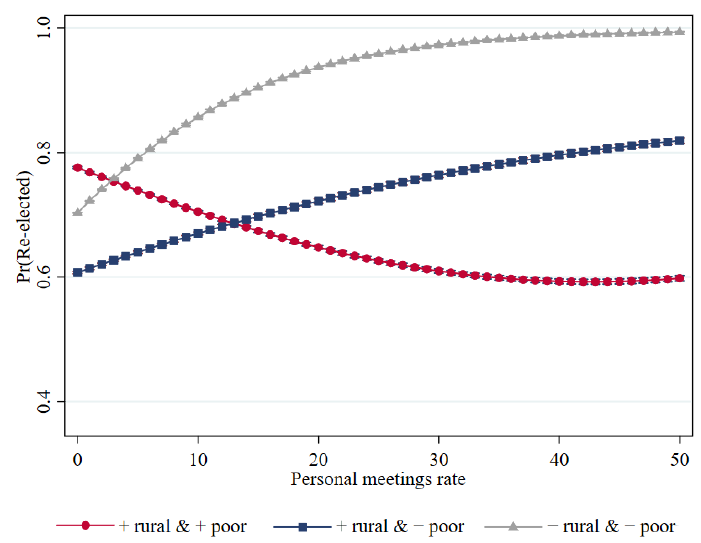
Figure 3. Predicted probability of re-election based on the personal meetings rate (by municipality group). Source: Prepared by the authors with data from www.servel.cl and www.infolobby.cl (accessed on 21 March 2021).